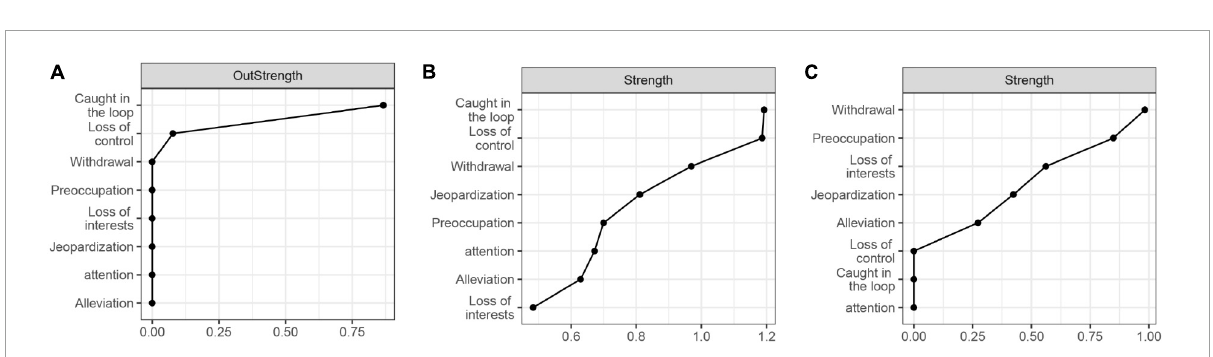
FIGURE4 Centrality of within- and between-subjects networks. (A) is the centrality of the temporal network, (B) is the contemporaneous network, and (C) is the between-subjects